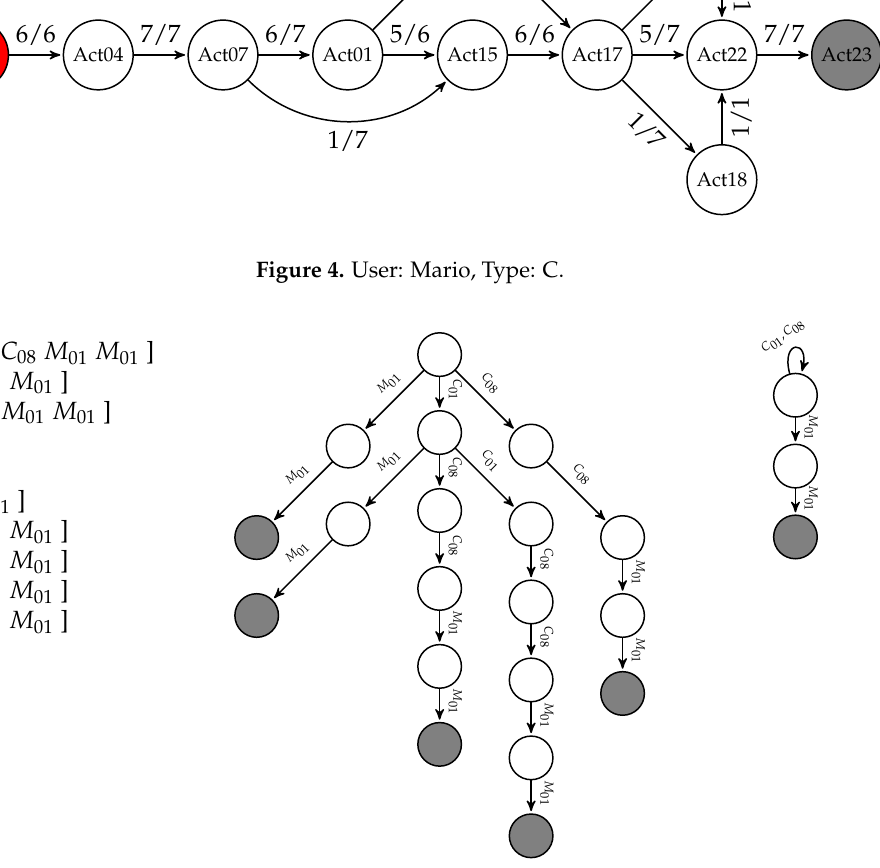
Figure 4. User: Mario, Type: C.